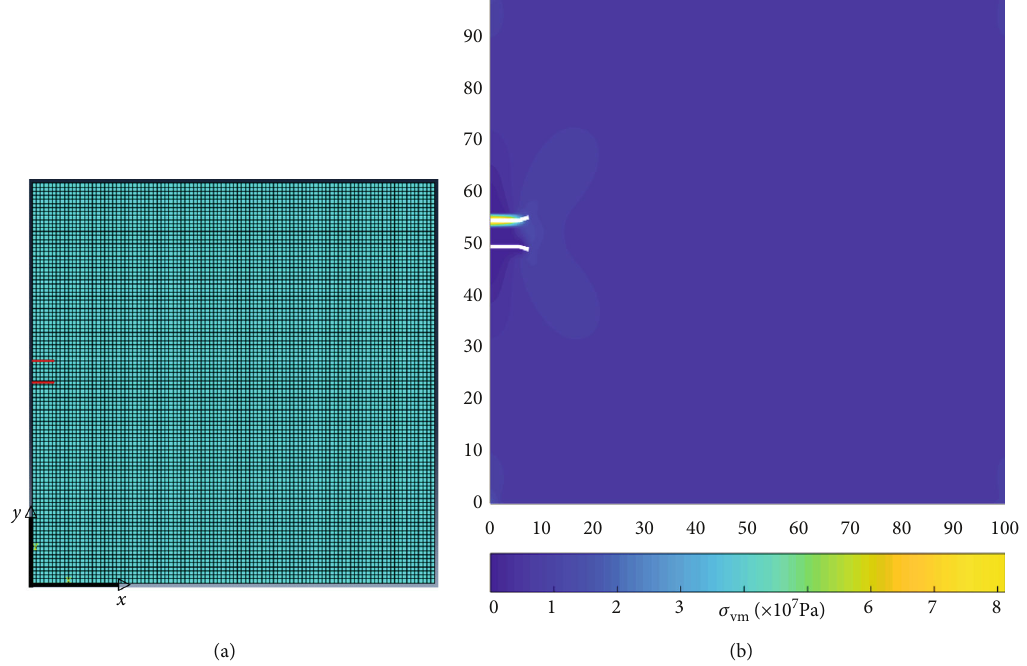
Figure 9: Results of the two-crack example, case 2: (a) mesh; (b) shaded plot of the von Mises stress σ